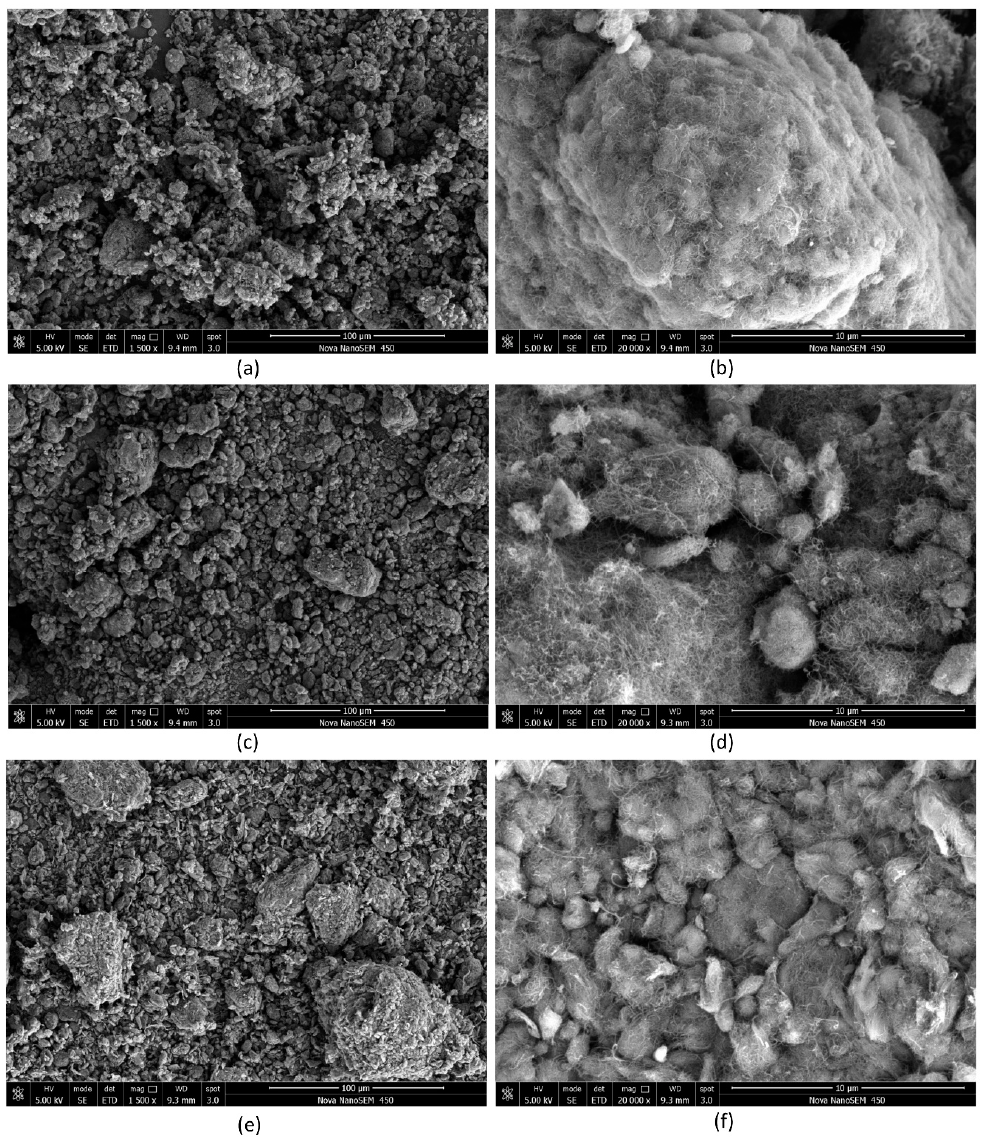
Figure 2. Microscopic morphologies of MWCNT powders with three different lengths (50 μ m: